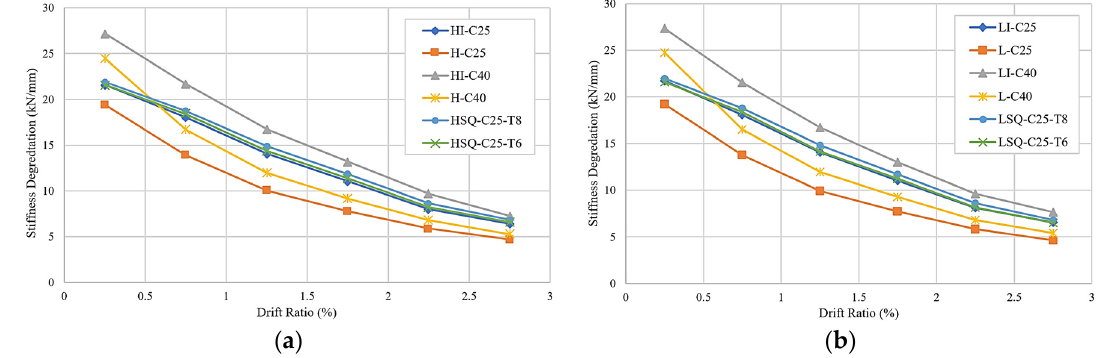
Figure 20. Stiffness degradation curves of frame models: ( a ) HD; ( b ) LD.